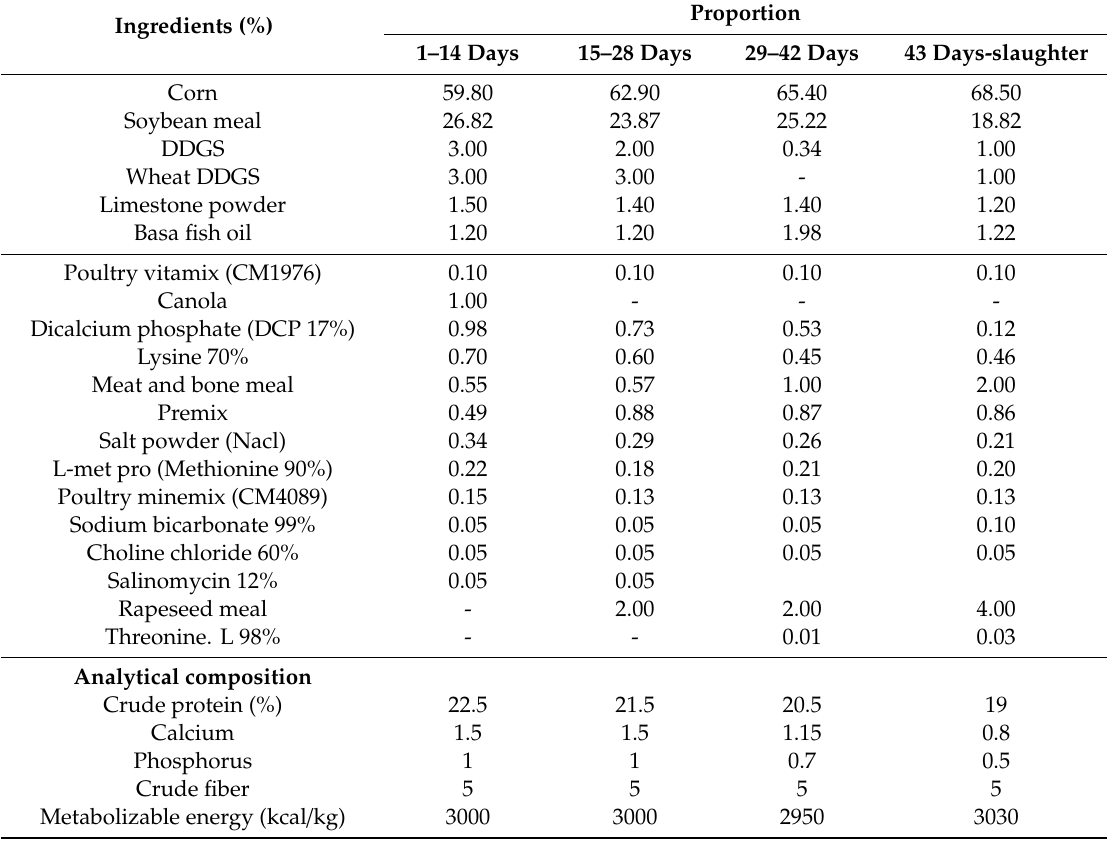
Table 1. Diet composition for broilers from the first day of age to slaughter.